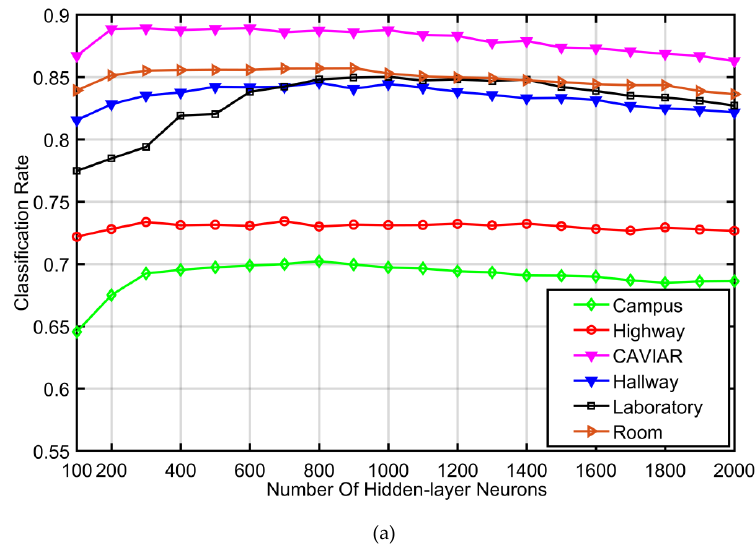
Table 5. Shadow detection comparison results with some representative deep-learning